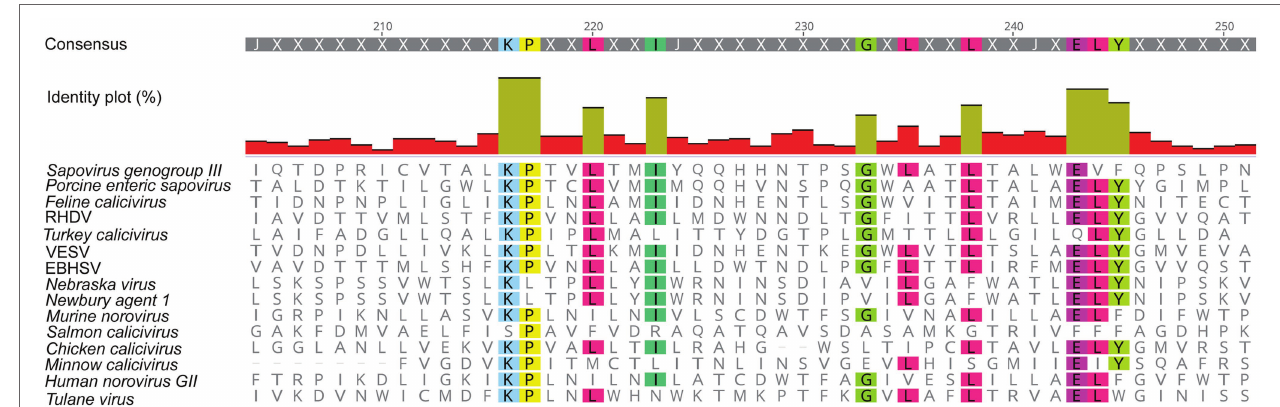
FIGURE 4 | Amino acid sequence alignment of the putative viroporin domain in the NS2 protein of various caliciviruses. The C-terminal region of all NS2 proteins contains a high degree of conserved amino acid residues (highlighted in color), as compared to the rest of the protein sequence. This figure was generated using the same sequences as in Figure 2B . RHDV, Rabbit haemorrhagic disease virus ; EBHSV, European brown hare syndrome virus ; and VESV, Vesicular exanthema of swine virus